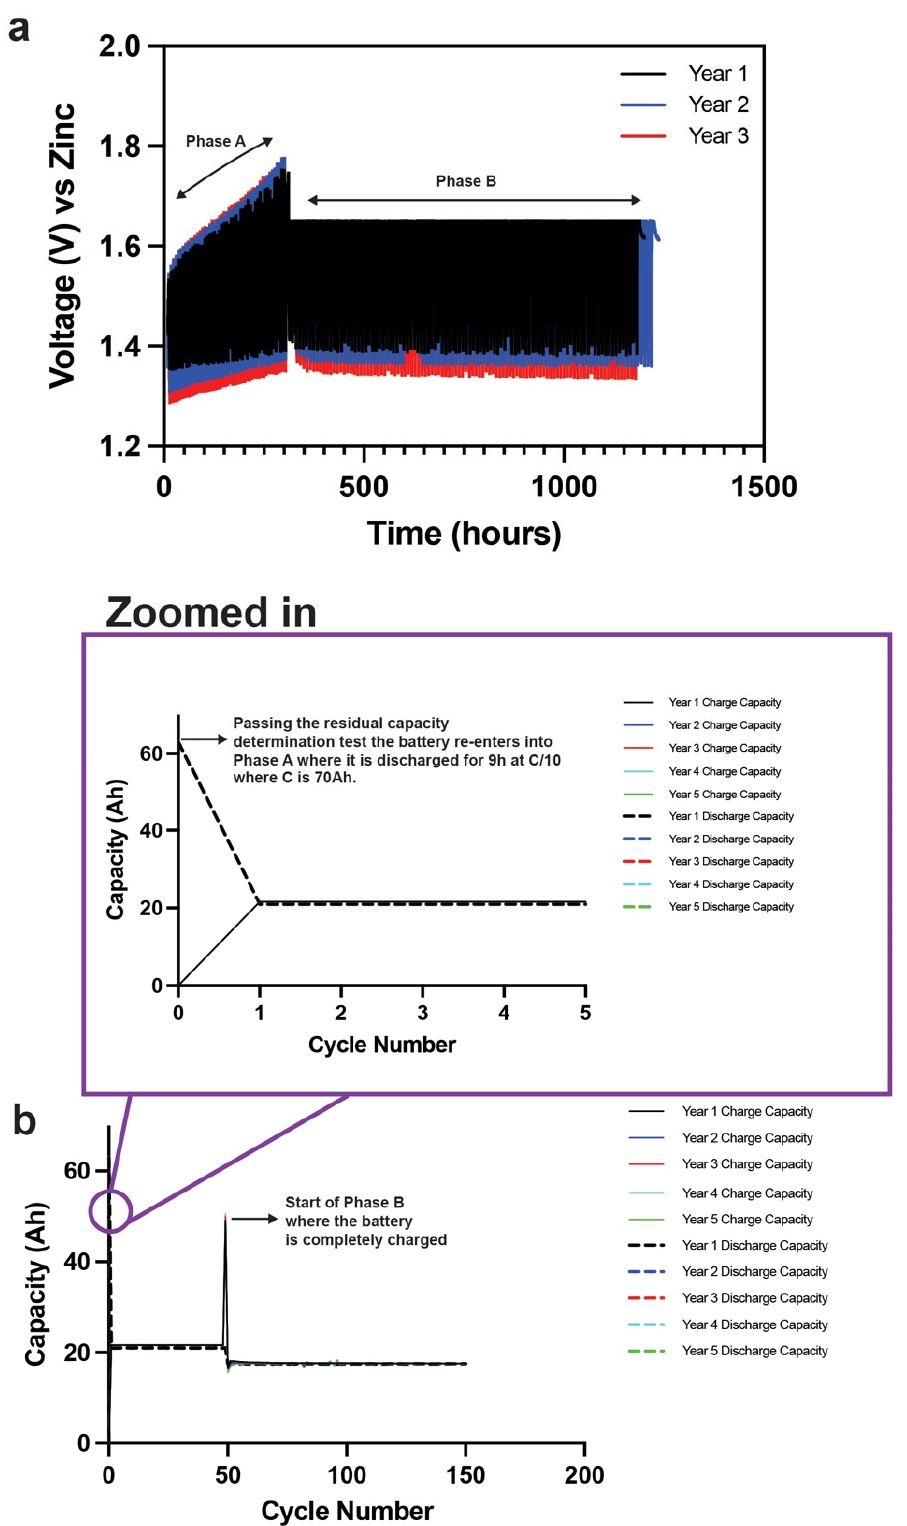
Figure 16. ( a ) Voltage–time curves of a commercial cylindrical 70 Ah Zn–MnO 2 cell containing hydrogel electrolyte cycled using the IEC solar off ‐ grid protocol. ( b ) Capacity retention of the hydrogel ‐ containing 70 Ah cylindrical cell passing through Phase A and B 5 times, thus equating to 750 total cycles. The cell is still cycling in its 6th year.